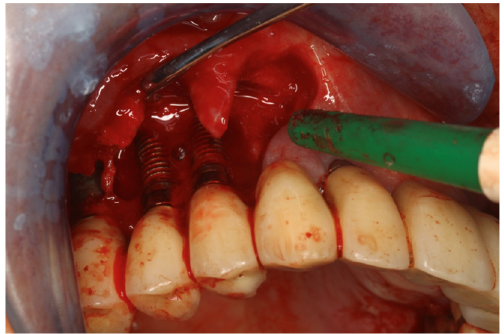
Figure 5. OHLLT surgical approach. Full thickness periodontal flap.